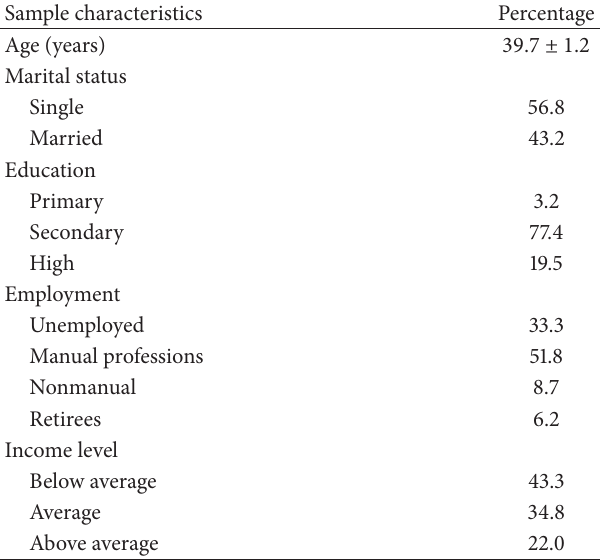
Table 1: Selected sample